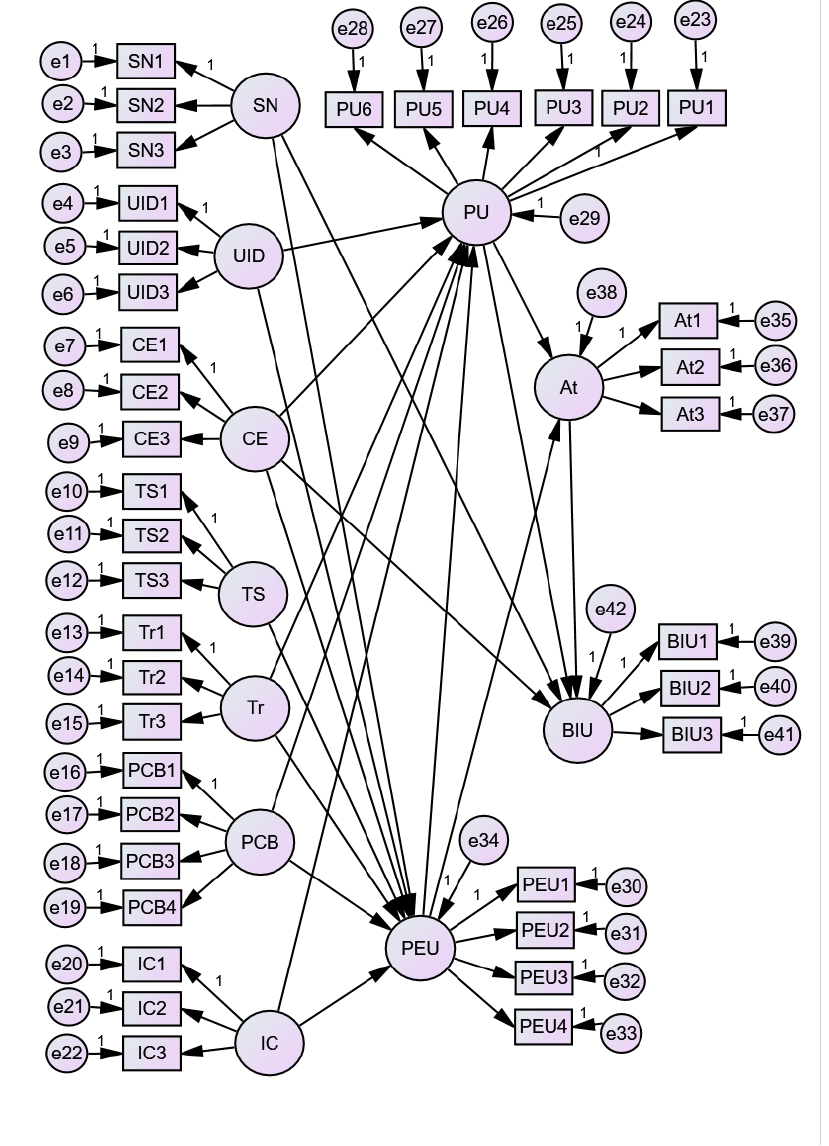
Fig. 3. Final best fitting structural